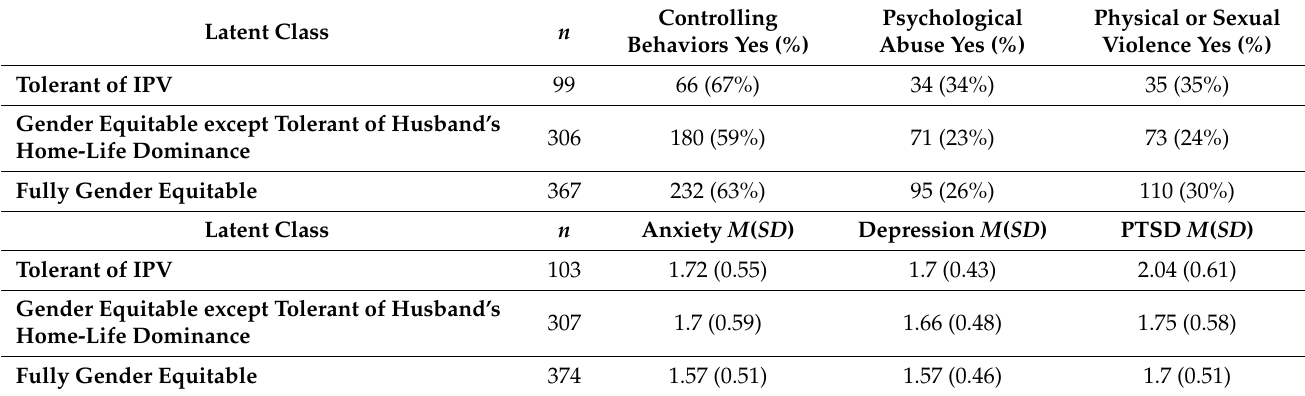
Table 4 disaggregates by latent class the frequency of ever having had experienced or perpetrated any of the different forms of IPV assessed and mean scores (range 1–4) of par- ticipants’ reported anxiety, depression, and PTSD. Using simple and multivariable logistic and regression, Table 5 compares the unadjusted and adjusted odds of experiencing or perpetrating different forms of IPV by class membership. Table 5 also explores associations between class assignment and mean scores for measures of anxiety, depression, and PTSD through simple and multivariable linear regression. For all analyses Tolerant of IPV serves as the reference group with adjusted models controlling for marital status and household food insecurity status. Table 4. Prevalence of ever-experienced IPV and mean mental health outcomes scores by latent